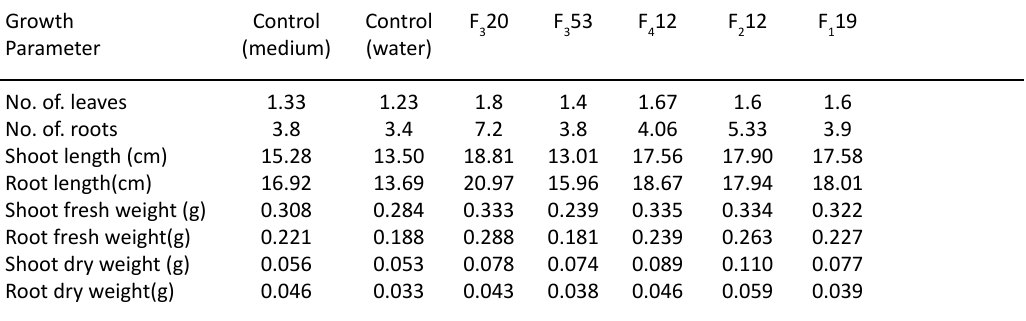
Table 2. Morphometric data of seedlings in paper towel method. Growth Control